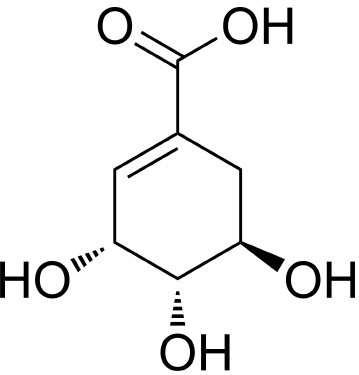
Figure 1. Structure of shikimic